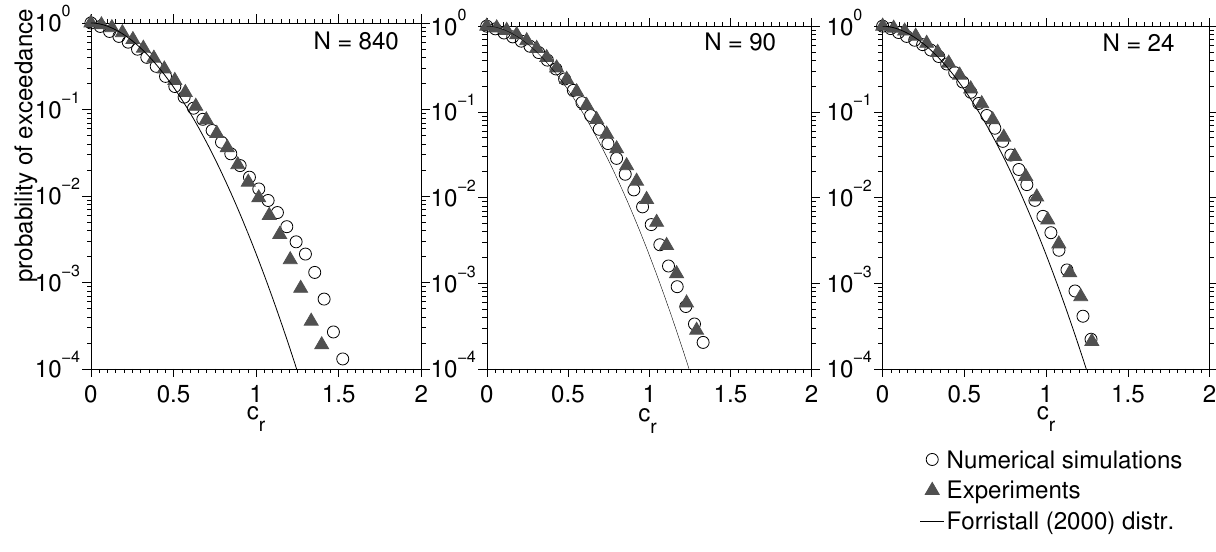
Fig. 7. Wave crests distribution: experiments and numerical simulations for a sea states with k p H s / 2 = 0 . 16.